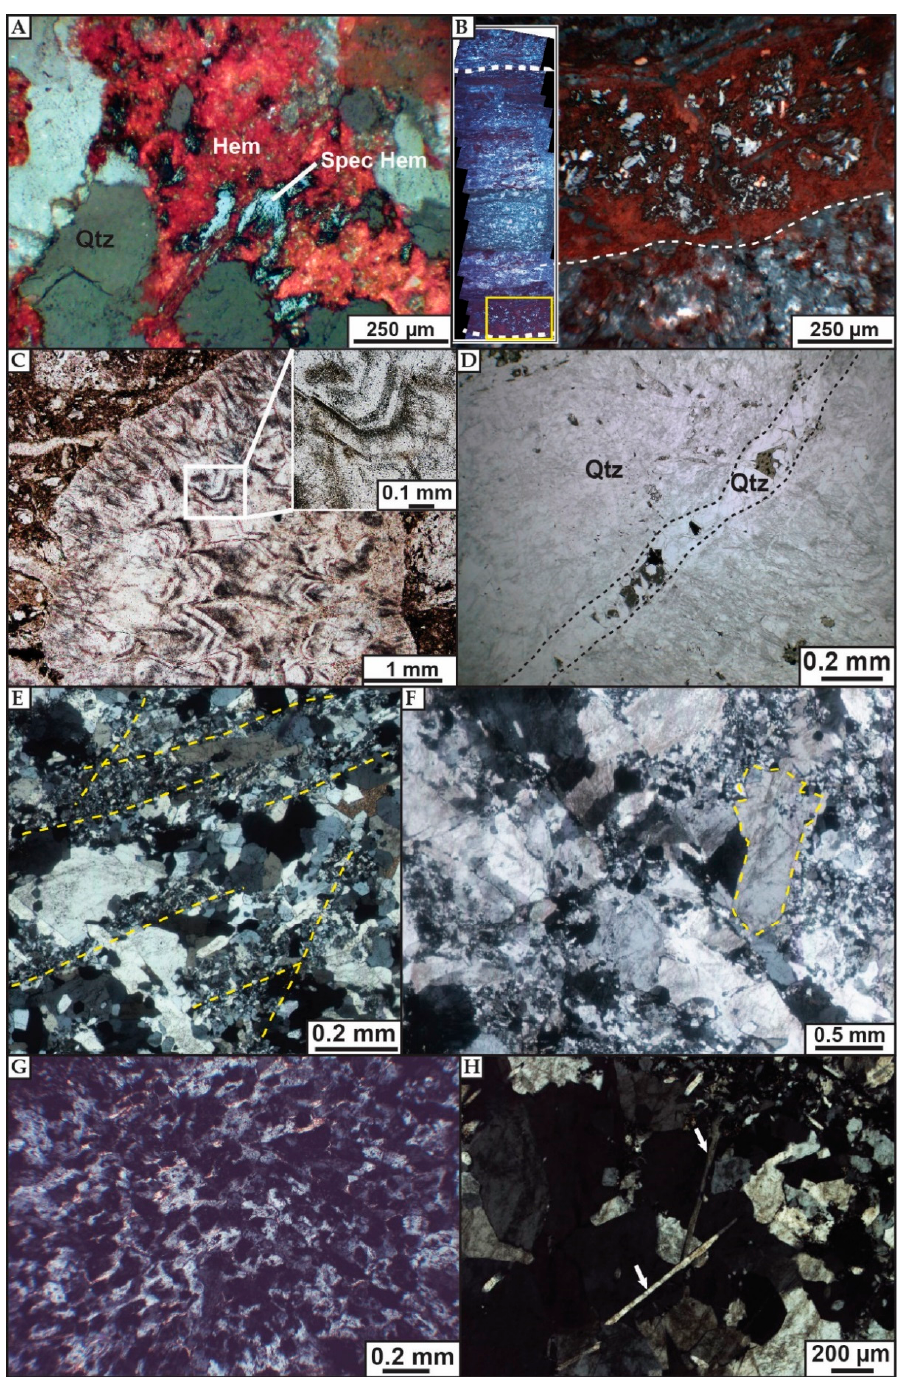
Figure 7. Optical microscope microphotograph (OM): ( A ) Disseminated hematite (Hem) and specular hematite (Spec Hem). Qtz: Quartz; ( B ) banded microcrystalline quartz (Qtz) with synchronous anhedral hematite and magnetite; ( C ) euhedral quartz crystals and arrays of dense monophase fluid inclusions (vapor rich); ( D ) euhedral clear quartz cement a fracture that crosscuts previous quartz generations; ( E ) trends of microcrystalline quartz (yellow); ( F ) comb quartz grains (example in yellow) engulfed in a fine-grained quartz matrix; ( G ) moss quartz texture; and ( H ) bladed lattice calcite (white arrow) replaced by quartz.